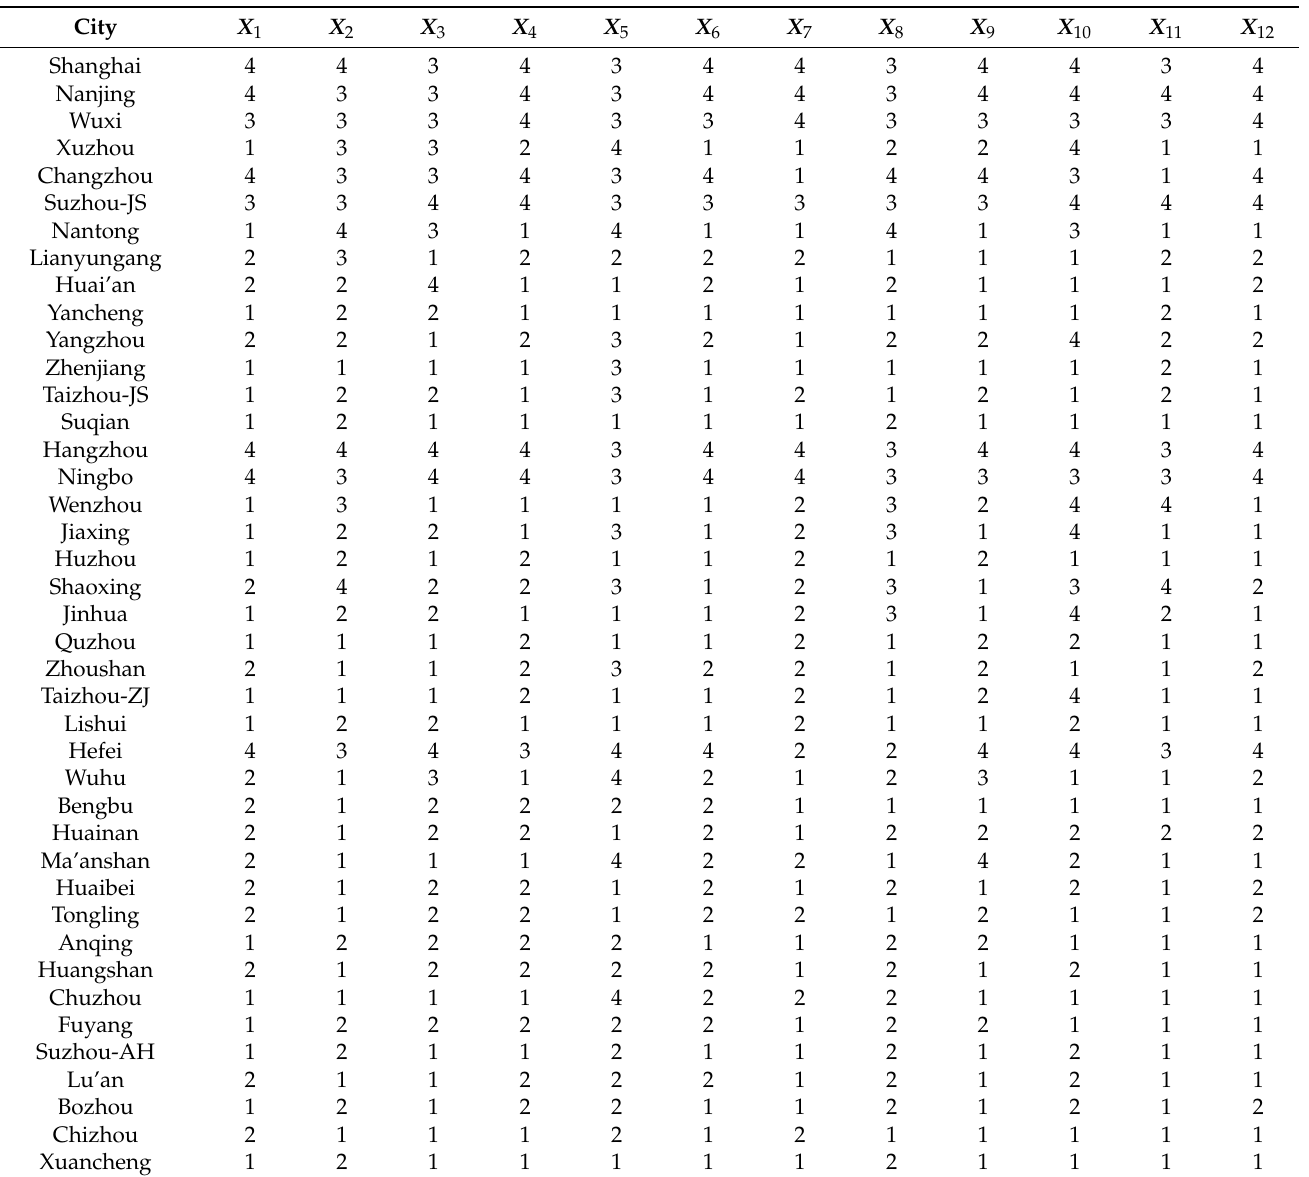
Table A2. Analysis of the evolution mode of independent variables in 2015–2019.